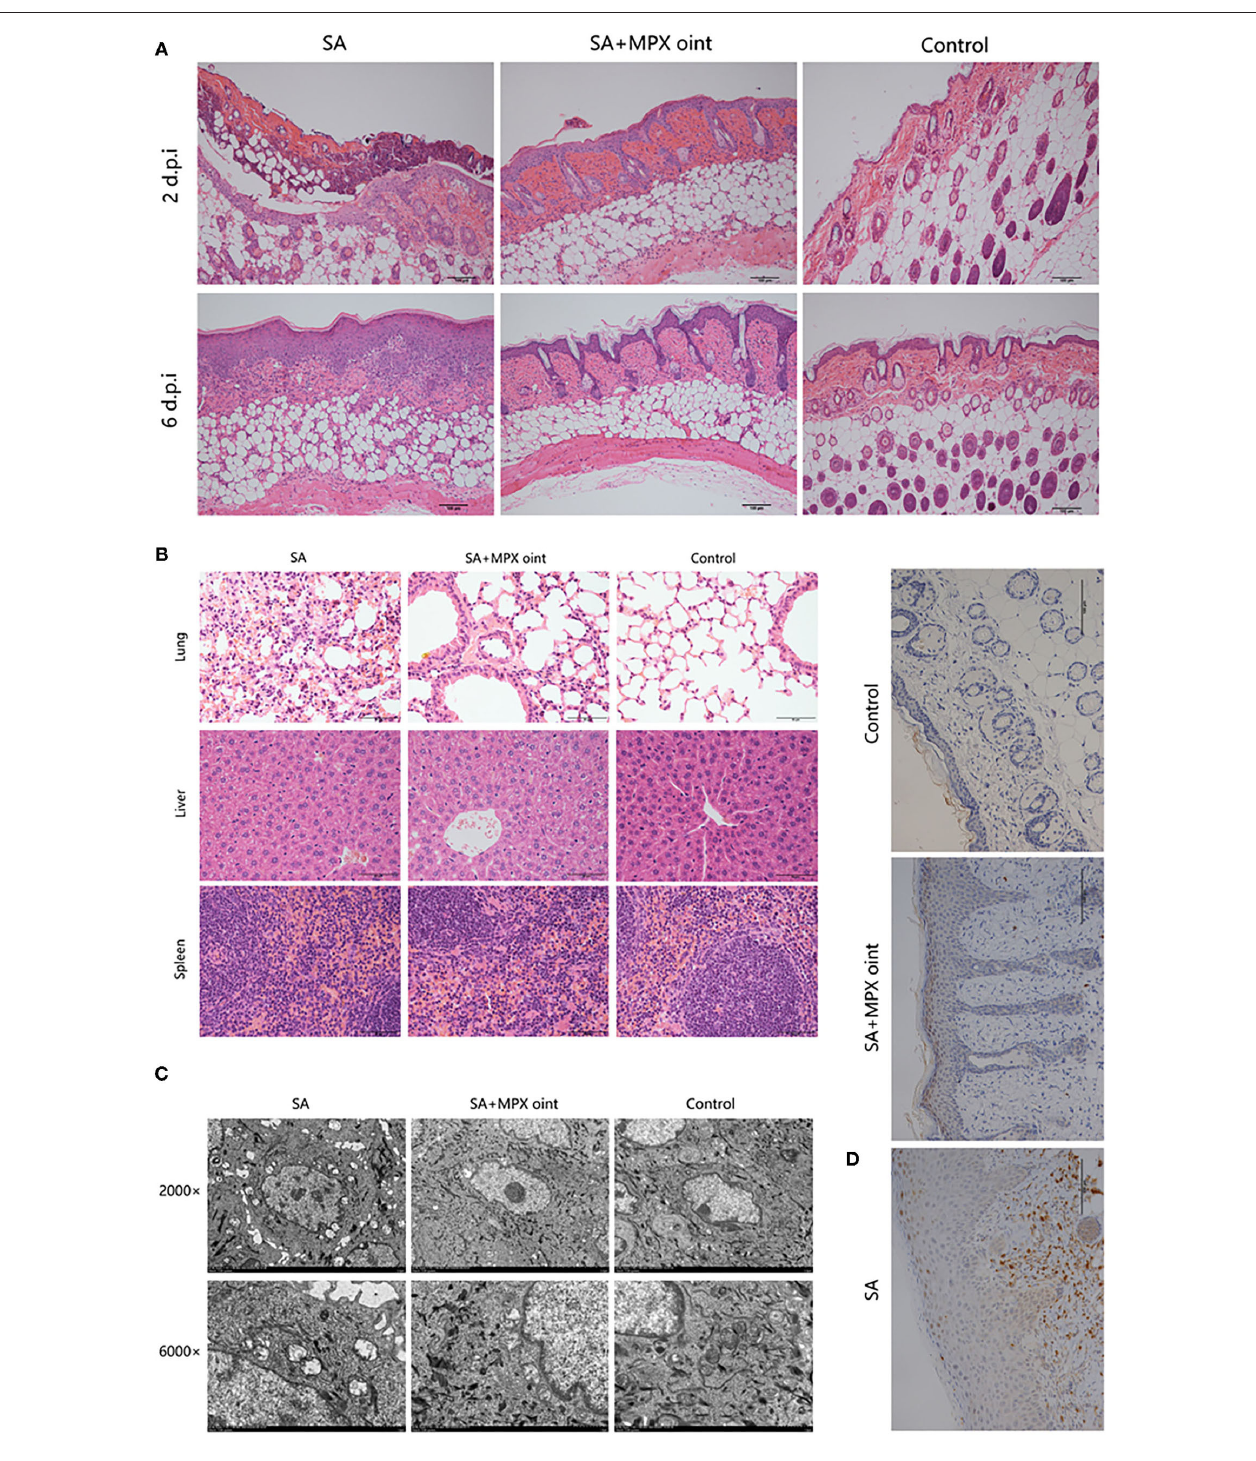
FIGURE 6 | MPX ointment can promote skin repair and reduce inflammation. Mice in each group were infected with S. aureus ATCC 25923 without treatment ( S. aureus /SA) or with treatment with MPX ointment ( S. aureus + MPX ointment/SA + MPX oint), and mice in an uninfected group did not receive any treatment (Control). (A) The results of HE staining of the wounded skin on the 2nd and 6th days after infection with S. aureus ATCC 25923. (B) HE staining results of the lung, liver, and spleen on the 6th day after S. aureus ATCC 25923 infection. (C) Transmission electron microscopy to observe the ultramicrocellular structure of the wounded skin on the 6th day after S. aureus ATCC 25923 infection. (D) Immunohistochemical observation of Ly6G expression in wound skin on day 6 after infection with S. aureus ATCC 25923.